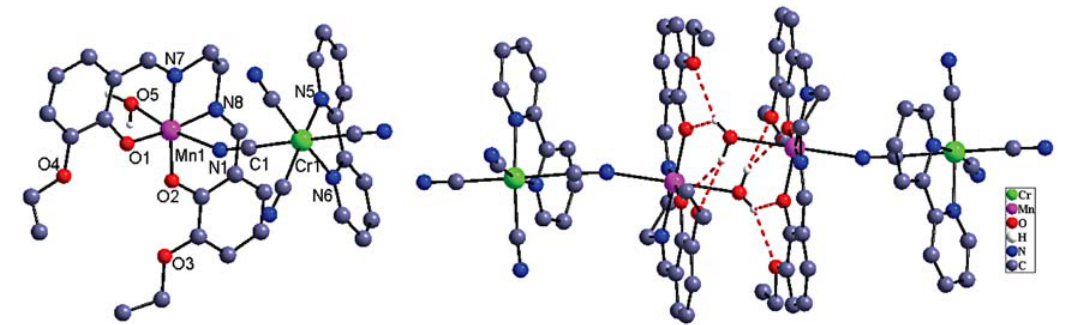
Figure 2. The neutral binuclear structure (left) and the dimer constructed by intermolecular hydrogen bond interactions (right) for complex 2 . Sol- vent molecules and the hydrogen atoms not involved in hydrogen-bonding have been omitted for